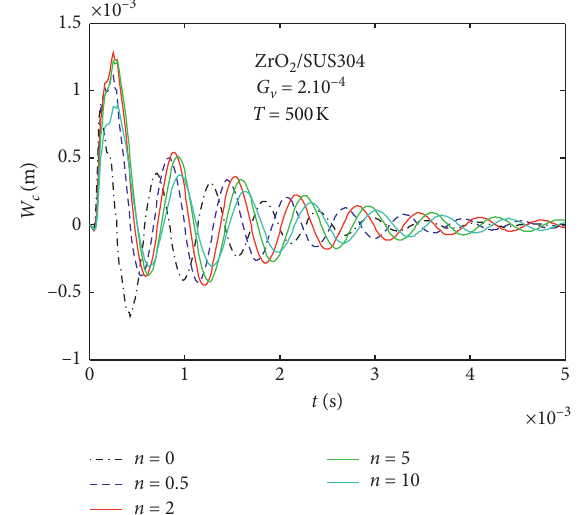
Figure 14: The dependence of w � 10, G � 2.10 − 4 k ∗ v 2